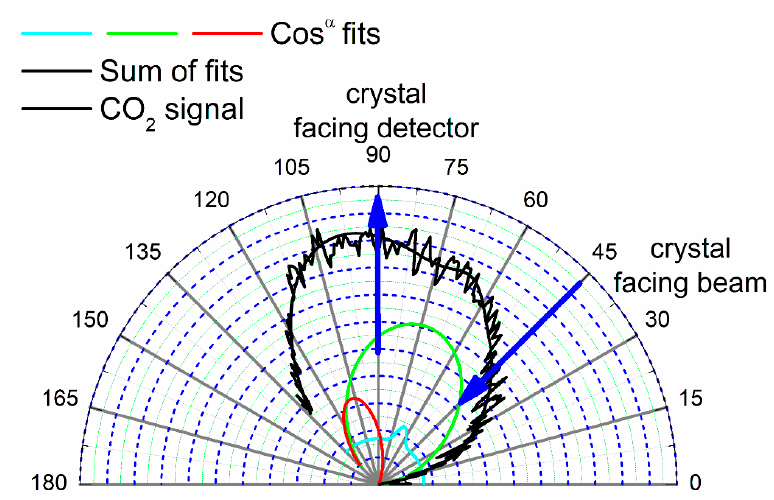
Figure 12. Angle-resolved CO oxidation experiment at T = 473 K. The CO 2 signal intensity is plotted as a function of the crystal polar angle. Three cosine α -shaped peaks are fitted simultaneously, and their sum are shown as solid lines.